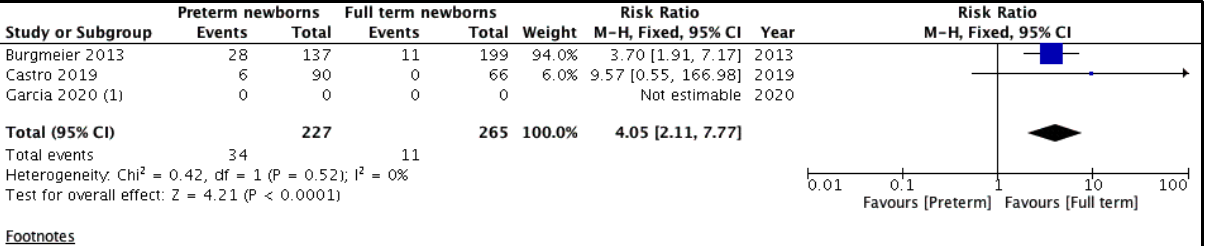
Table 3. Postoperative complications among the preterm and full-term infants.